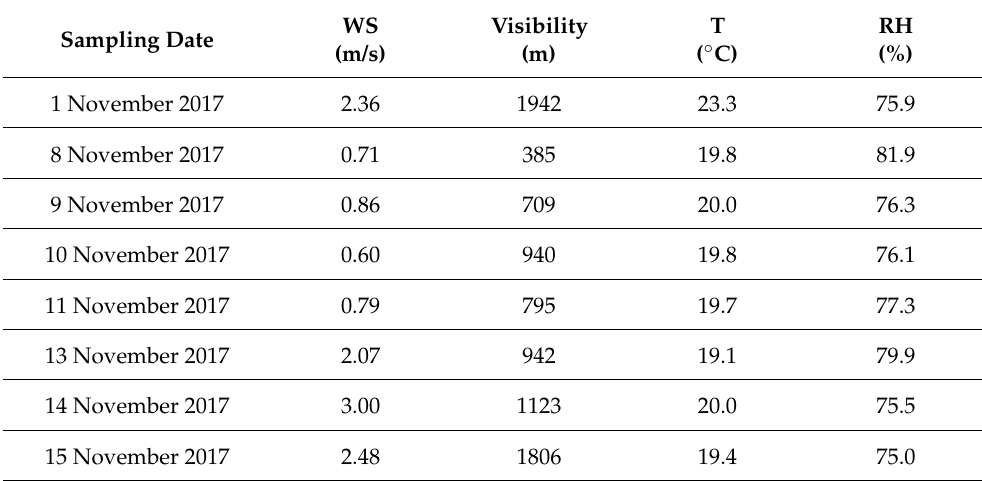
Figure 2. Variations in PM 2.5 concentration (µg/m 3 ) during Smog Event-2017. Table 2. Day-wise variations in meteorological parameters during Smog